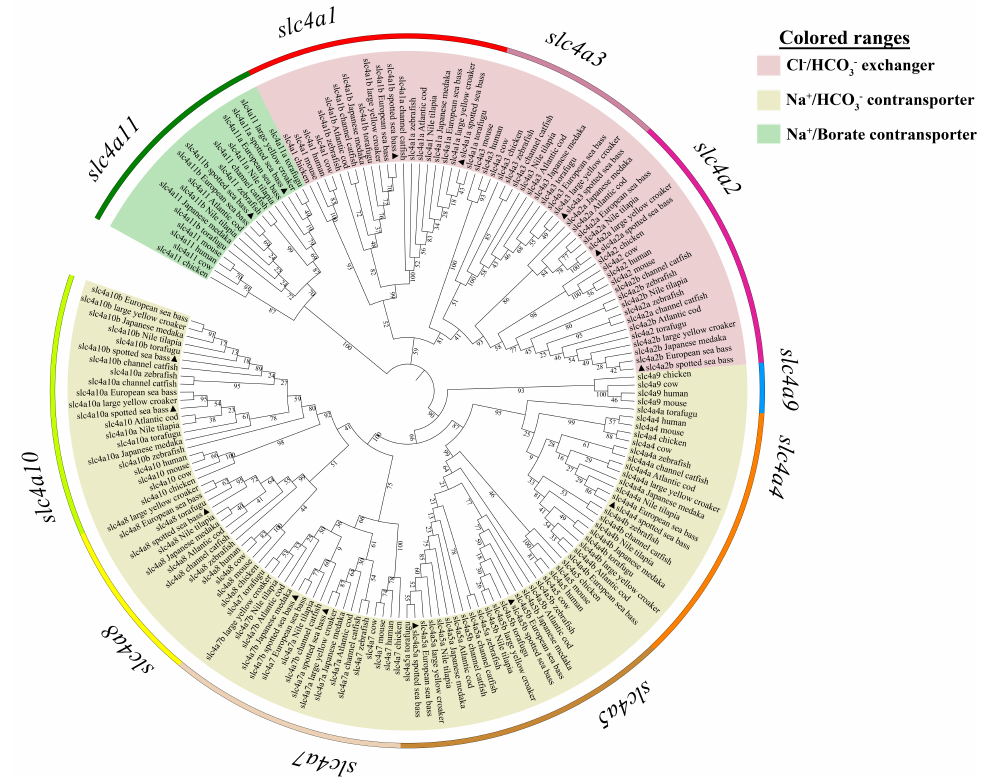
Figure 1. Phylogenetic relationships of slc4 genes in spotted sea bass and selected vertebrate